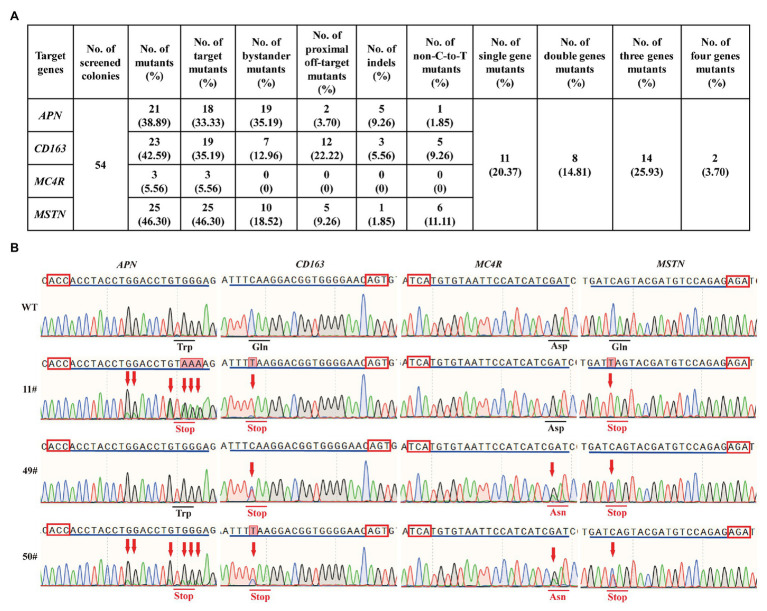
hA3A-BE3-NG-mediated base editing at multiple genes in PFF cells. (A) Summary of multiple sites base editing by hA3A-BE3-NG in PFF cells. (B) Sanger sequencing results of selected single-cell colonies. 11# and 49# colonies have mutations on three genes, and 50# colony has mutations on all four genes. The red box indicates the PAMs and the blue line indicates the sgRNA sequence. The red arrow indicates the substituted nucleotide. The amino acid in the red line indicates expected substitutions at target sites.